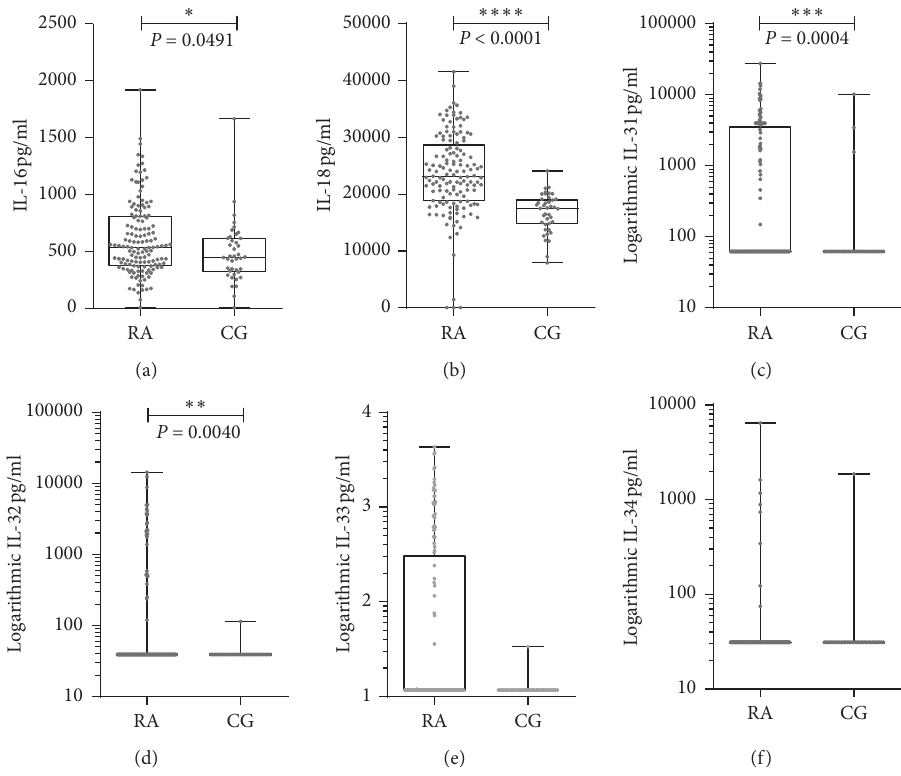
Figure 1: Cytokines serum evaluation: IL-16 (a), IL-18 (b), IL-31 (c), IL-32 (d), IL-33 (e), and IL-34 (f) levels in RA patients (140) and control group [29]. IL-16, -18, - 31, and -32 were found at high levels in RA patients (Mann–Whitney test).